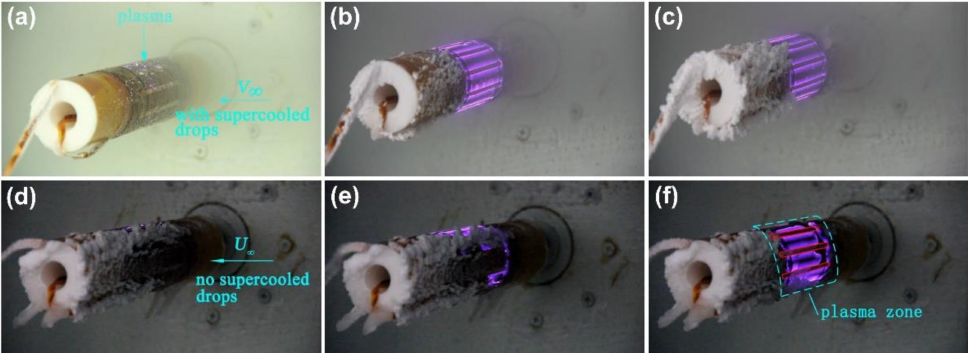
Figure 12. Anti-icing ( a – c ) and deicing ( d – f ) DBD plasma multi-actuator model at V = 15 m/s and T = − 10 ◦ C after: ( a ) t = 0 s, ( b ) t = 210 s, ( c ) t = 930 s, ( d ) t = 0 s, ( e ) t = 120 s, ( f ) t = 180 s (adapted from Cai et al. [29] with the permission of